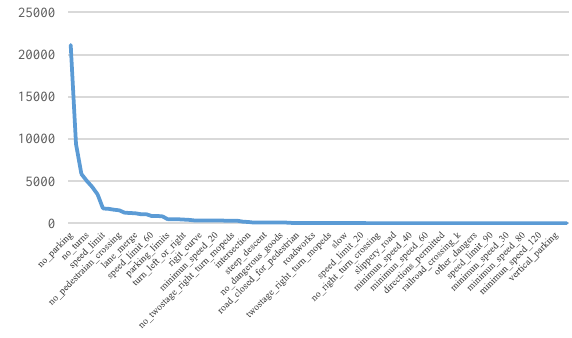
Figure 1. The number of Traffic Sign Samples in Real Scene